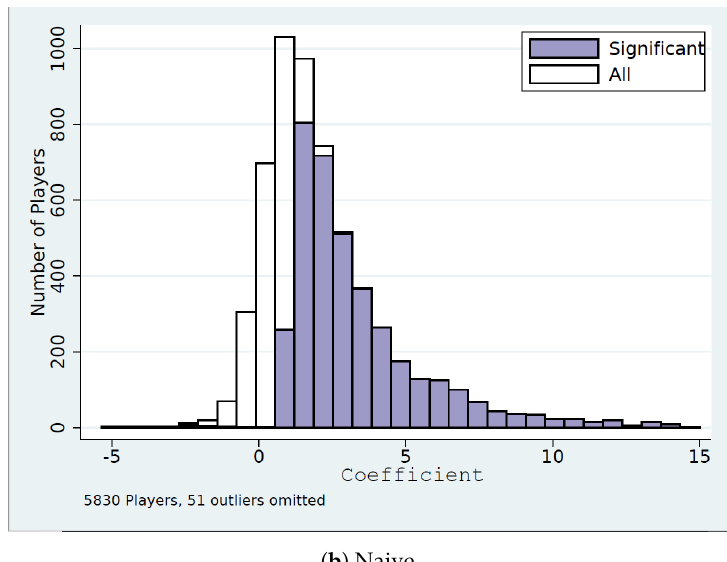
Figure 7. Distribution across players of the coefficient in the quantal response model. Note: The coefficient is β from the logit estimation, run separately for each player, U rock analogously for paper and scissors, where EP (the expected payoff) for the baseline model is the probability of winning against the opponent’s historical distribution minus the probability of losing; for the naive model is just the probability of winning. Outliers more than 4 standard deviations from the mean are